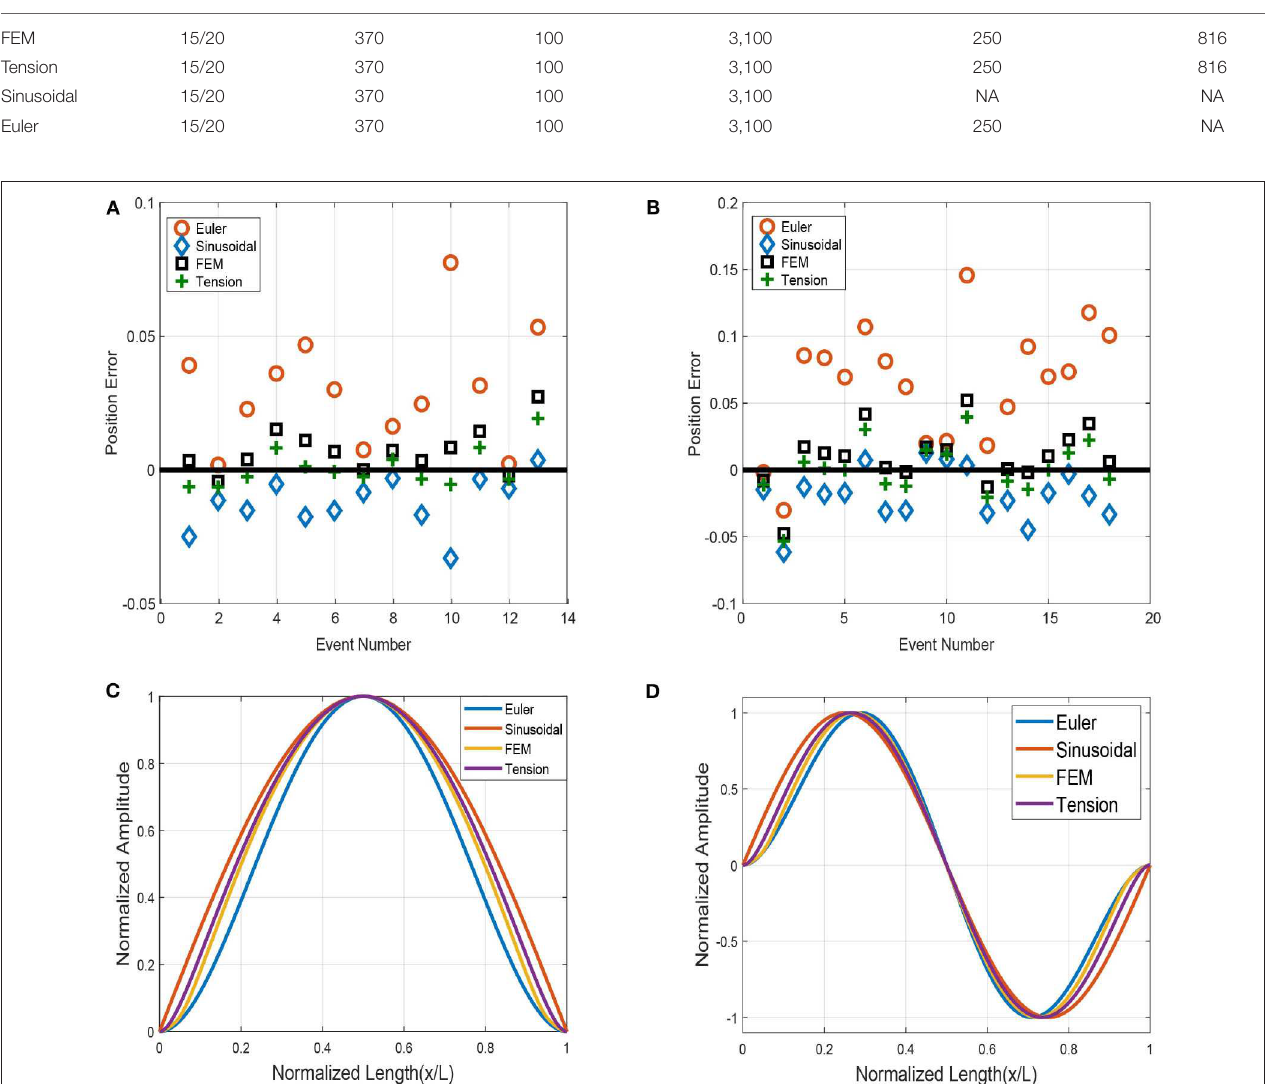
FIGURE 5 | Position errors of different mode shapes according to positions of particles marked in SEM imaging of (A) the 15 µ m beam, and (B) the 20 µ m beam for different beam models. (C) Mode shapes of the 1st Vibration Mode (D) Mode shapes of the 2nd Vibration